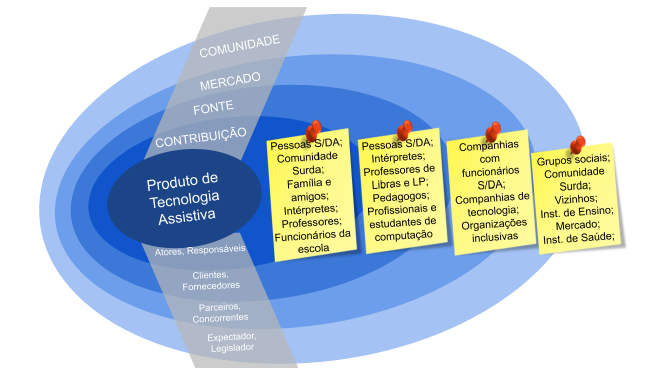
Fig. 3. Stakeholders Diagram of the 2nd SPW